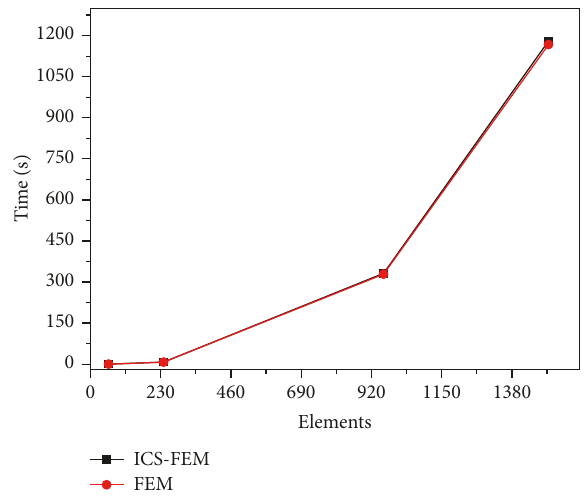
Figure 10: Comparison of computational efficiency.